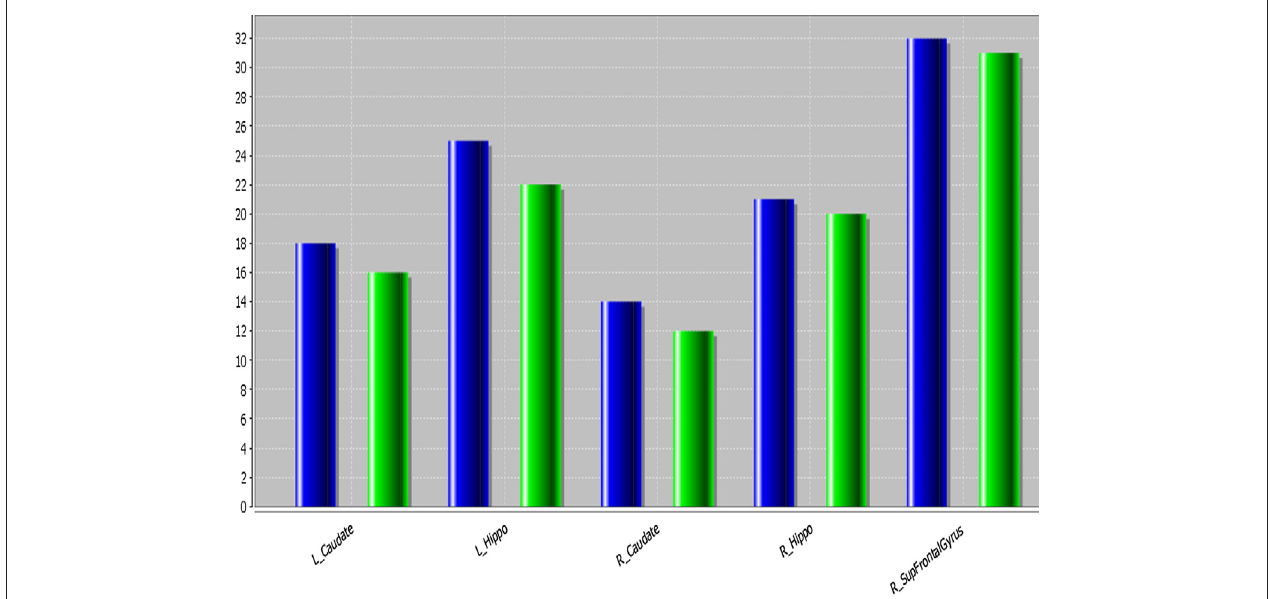
FIGURE 5 | NC shape-curvature measure for 5 ROI’s at two times ( T1 , baseline, blue, and T2 , 12-month follow-up, green). L_Caudate and R_Caudate , left and right caudate, L_Hippo and R_Hippo , left and right hippocampus, R_ SupFrontalGyrus , right superior frontal gyrus.